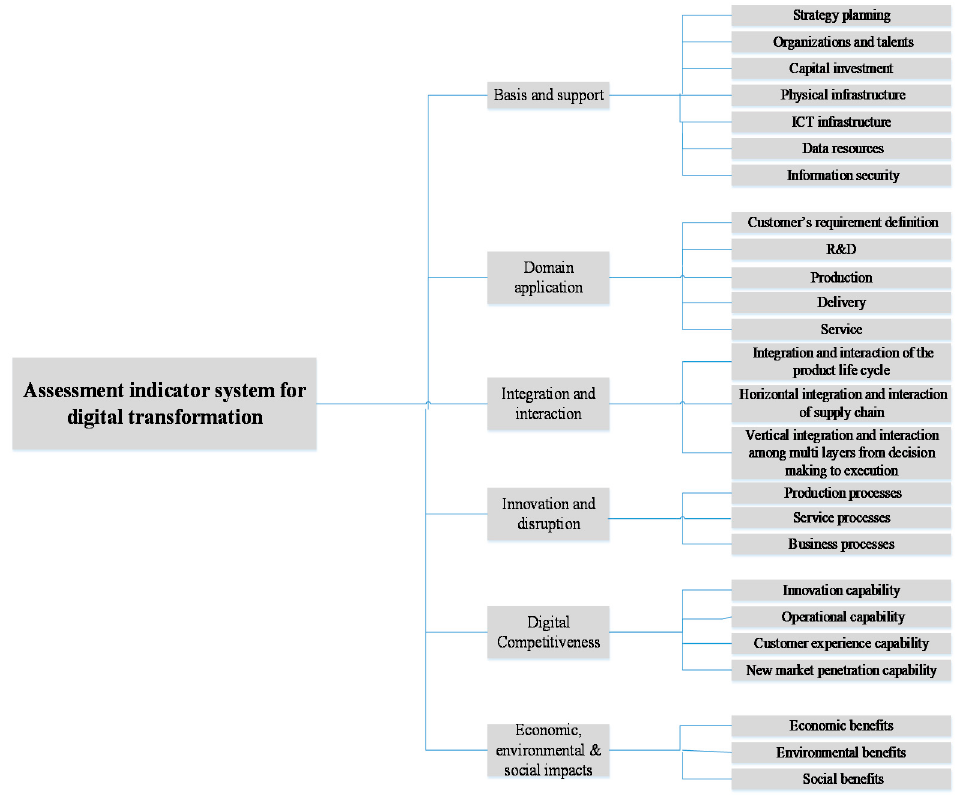
Figure 2. Assessment indicators of enterprises’ digital